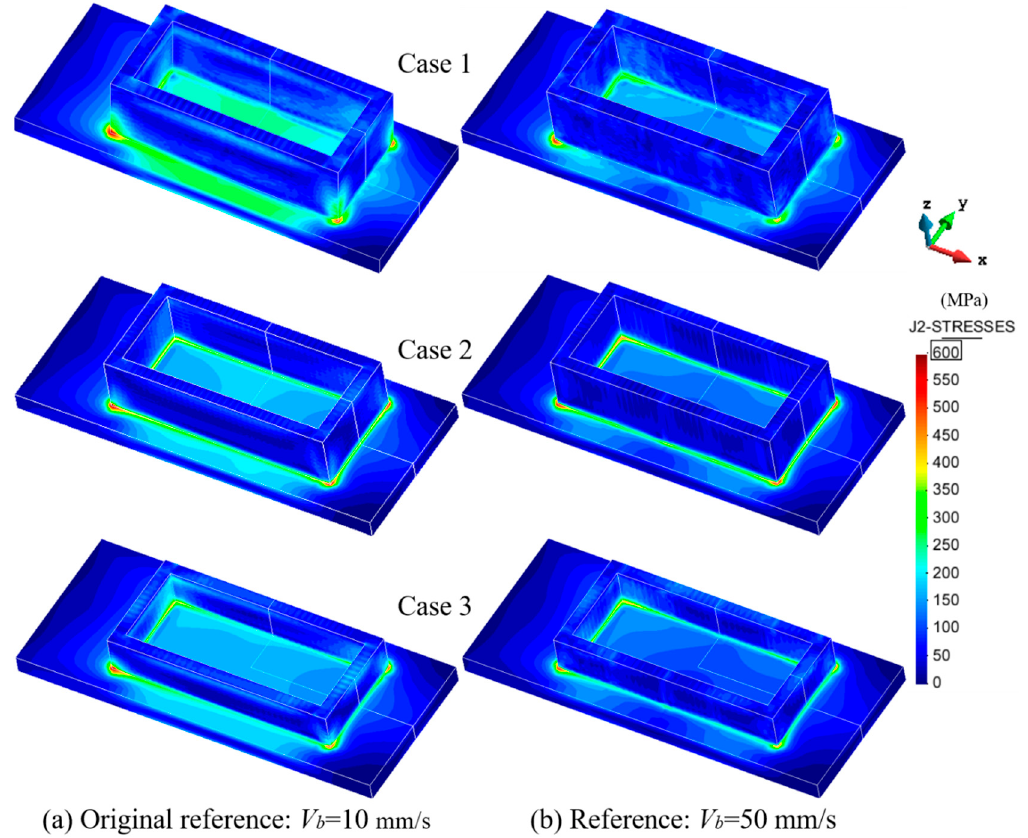
Figure 10. Residual von Mises stress fields for the three cases in Table 1 and two di ff erent back speeds.